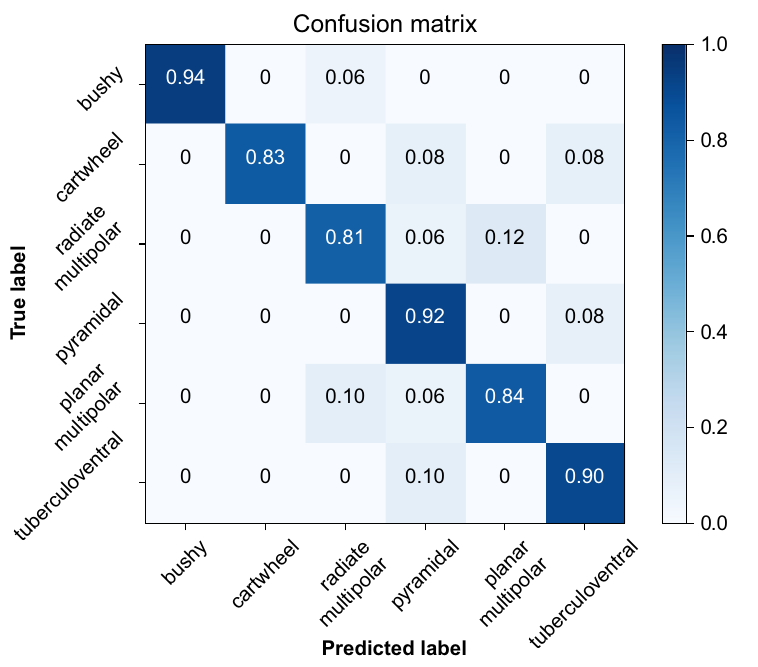
Fig 7. Prediction accuracy table (confusion matrix) by cell type. The most frequent mis-classifications occurred amongst cells with similar general firing patterns, such as planar and radiate multipolar cells, and pyramidal and tuberculoventral cells. This table was generated in R using data from all 12 measures. The numbers in each box indicate the proportion of correct classifications for each cell type.